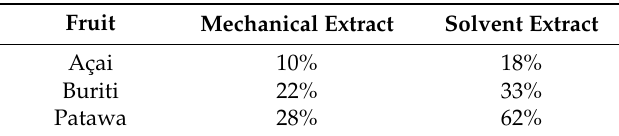
Table 1. Extraction yield for açai, buriti and patawa oils obtained by mechanical and solvent extraction. (oil weight / dry material weight).